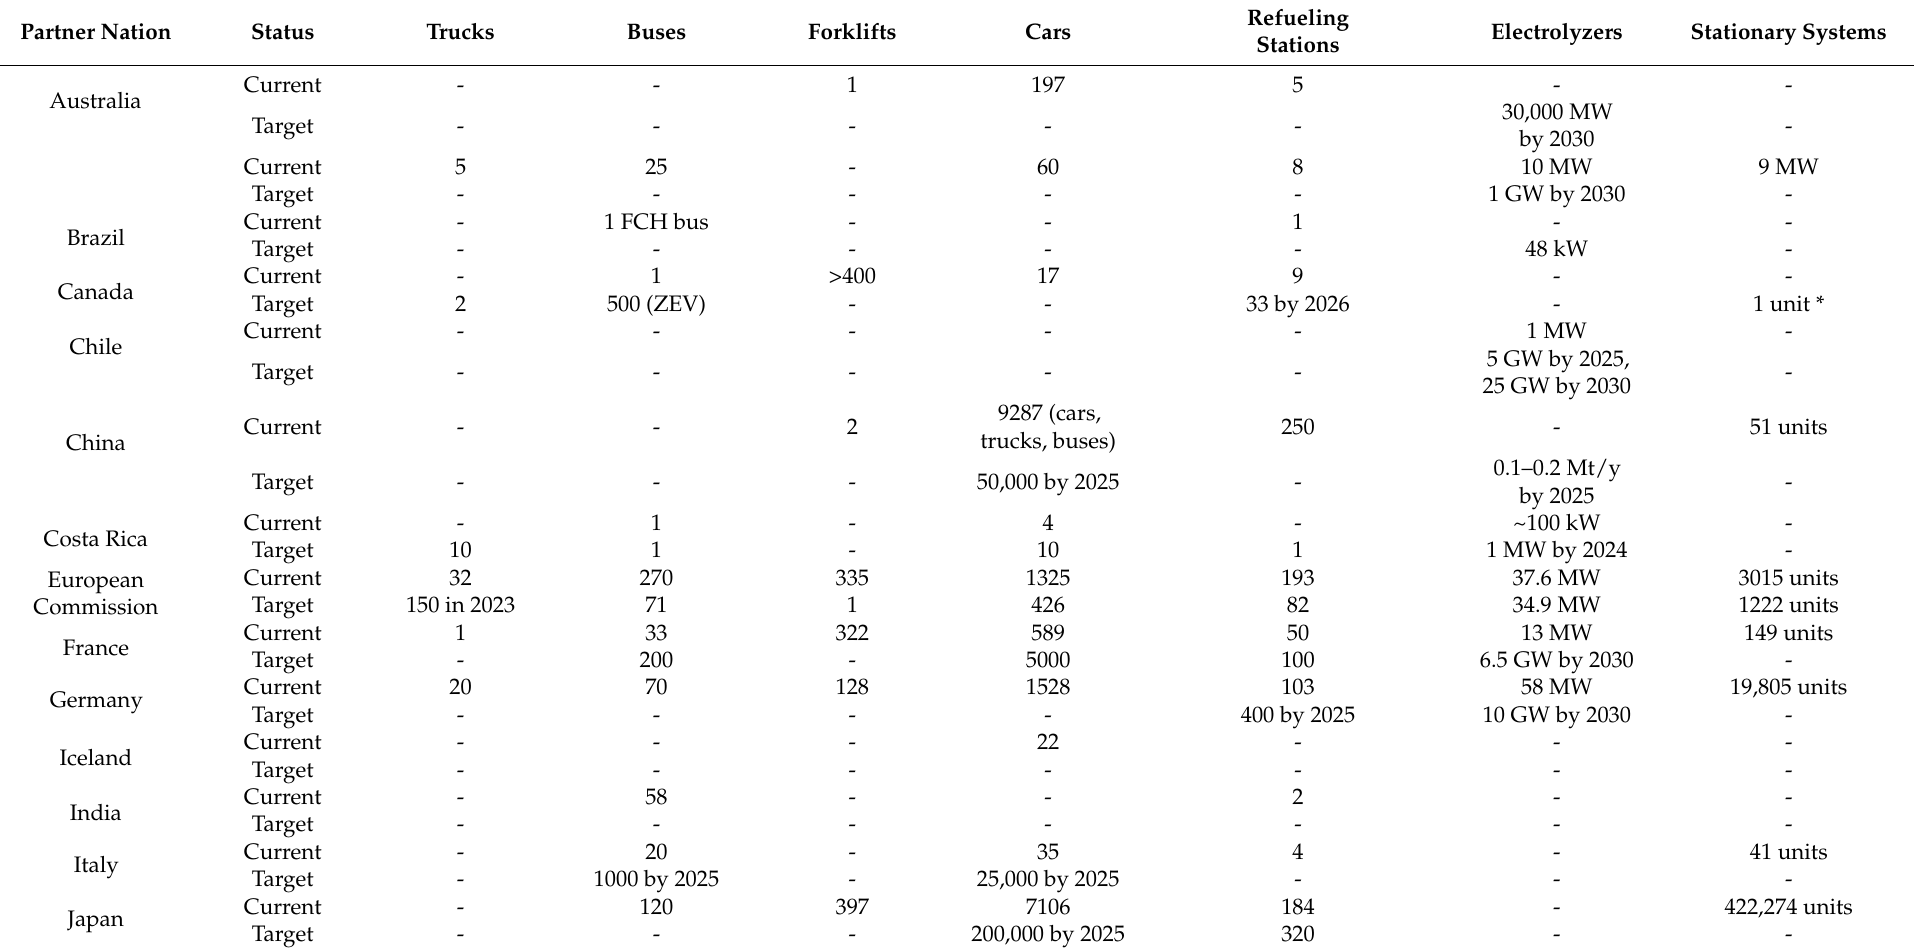
Table 12. Fuel cell unit deployment status in partnership with